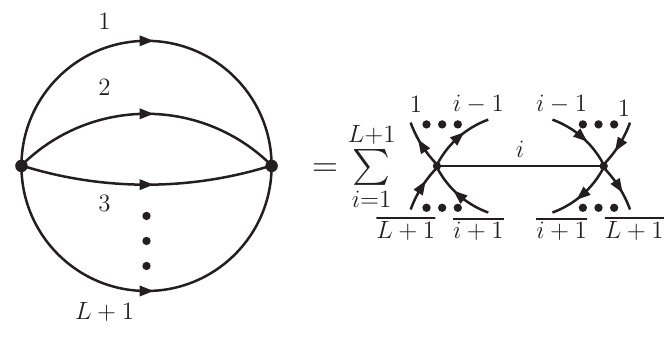
Figure 4 . Opening of MLT ( L ) topology into non-disjoint